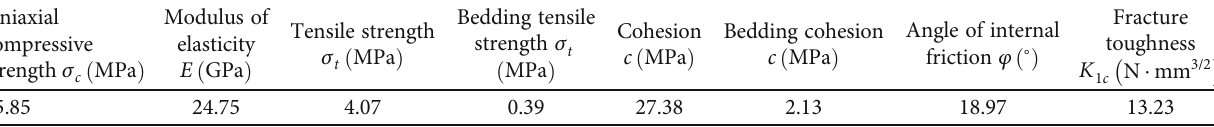
Table 1: Mechanical parameters of each part of the test block.